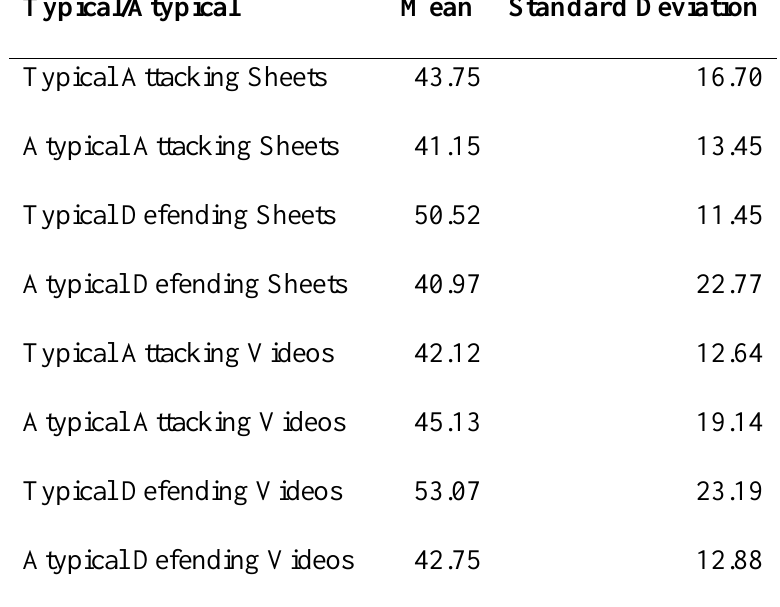
Table 3.2 – Mean and standard deviation values for Typical and Atypical